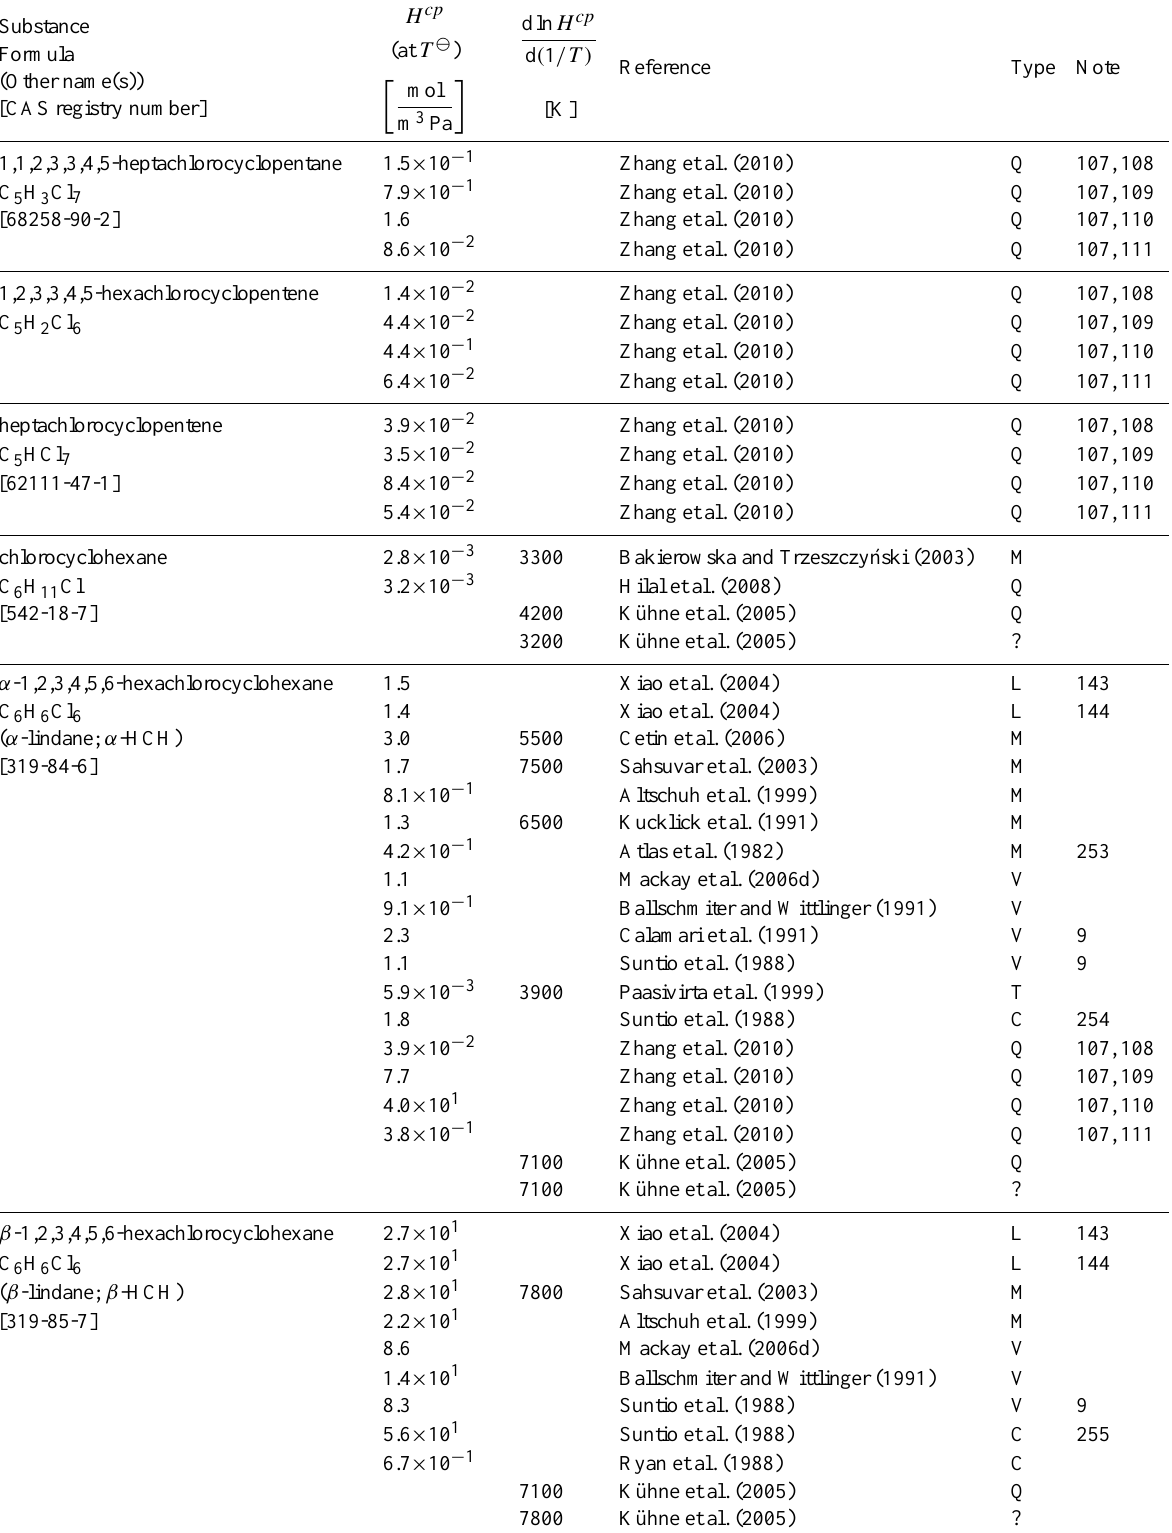
Table 6: Henry’s law constants for water as solvent